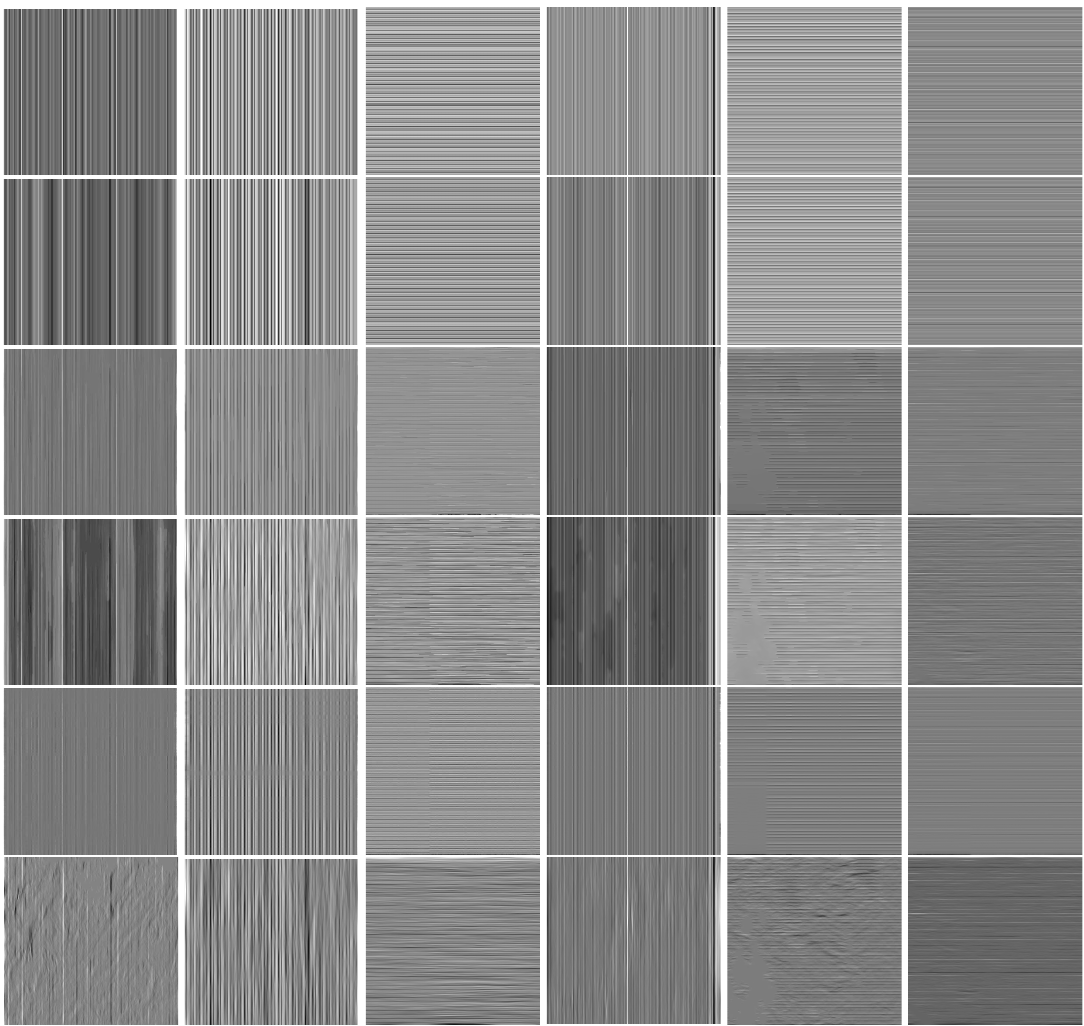
Figure 8. The stripes s of different real images in Figure 7. From top to bottom: the extracted stripe components of WFAF, SLD, UTV, GSLV, LRSID, and Ours. Table 4. The MICV and MMRD index results of the six real